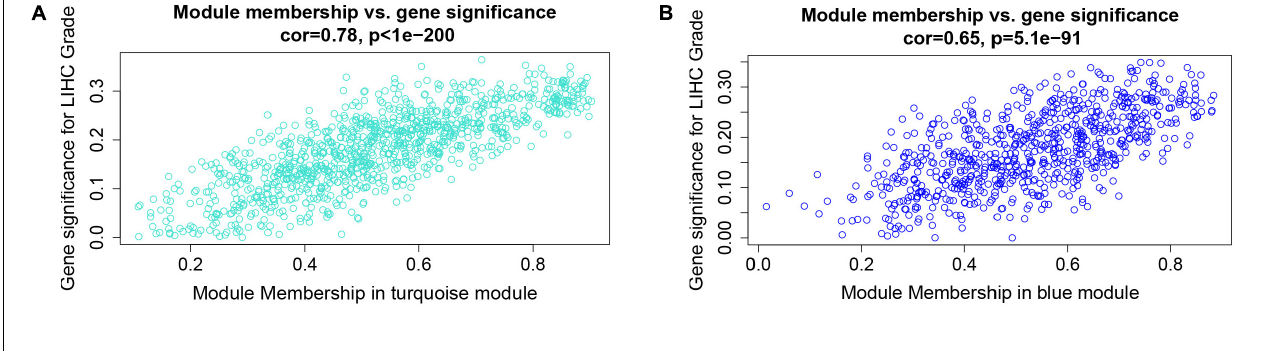
Frontiers in Genetics |